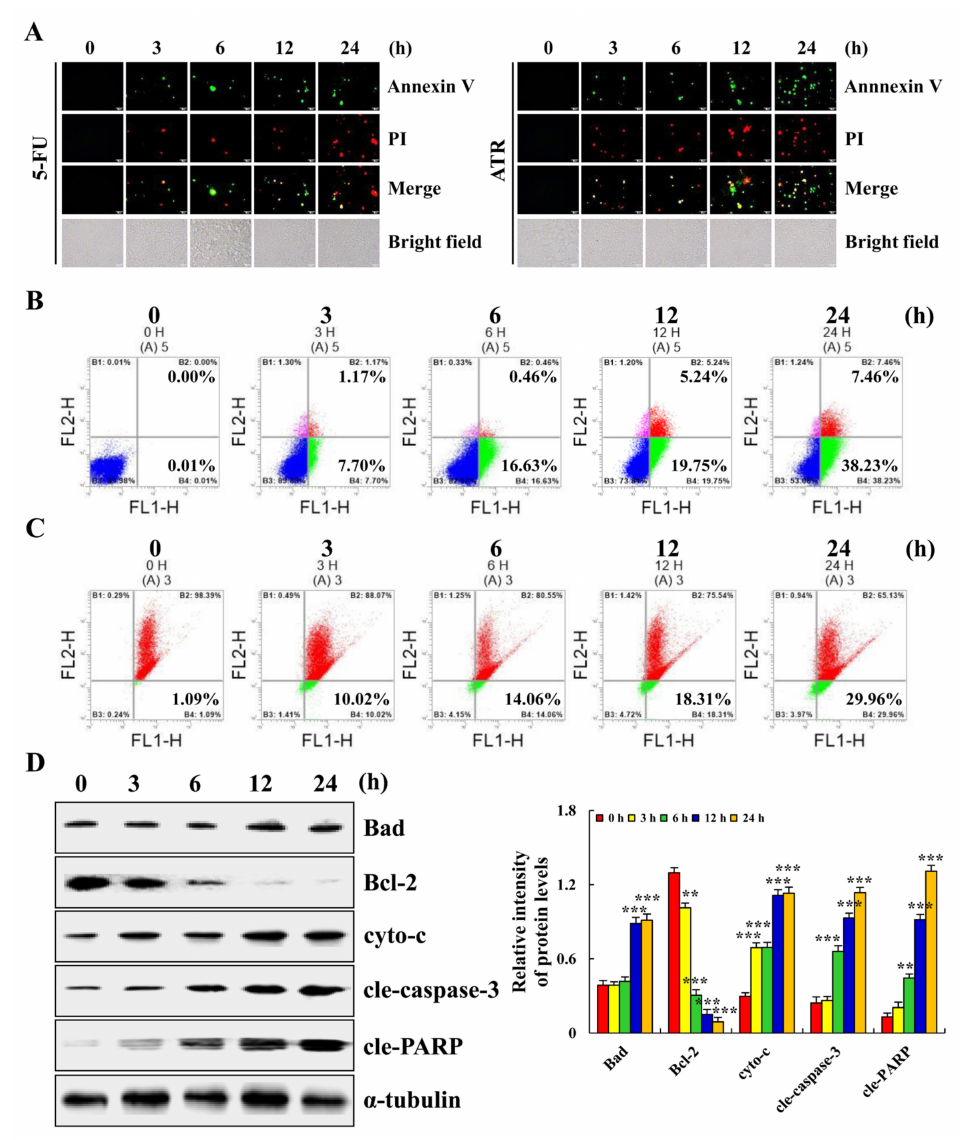
cle-PARP were increased, while the expression levels of antiapoptotic protein Bcl-2 were decreased, further confirming the above conclusion (Figure 2D).